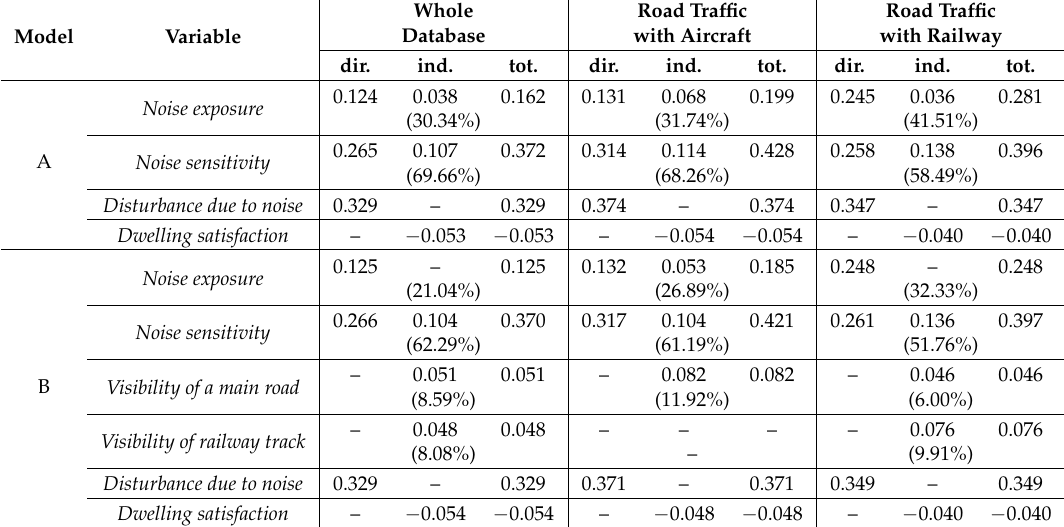
Table 4. Direct (dir.), indirect (ind.) and total (tot.) effects of all variables affecting noise annoyance due to road traffic noise in Models A and B. Contributions of exogenous variables are given in percentage between